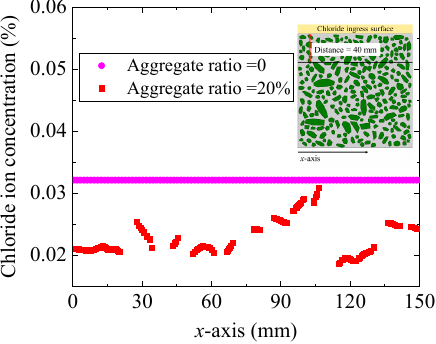
Figure 10. Chloride concentration distribution at the 50th.